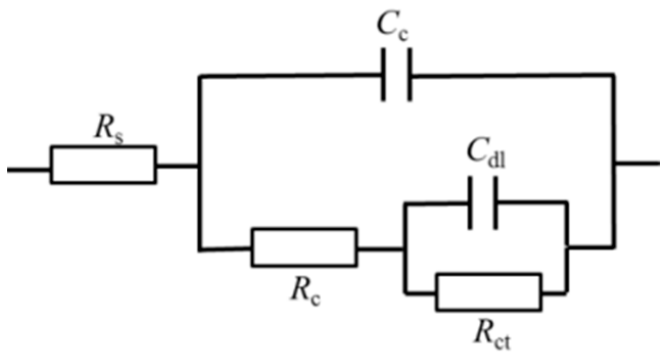
Figure 7. Equivalent circuit diagram.